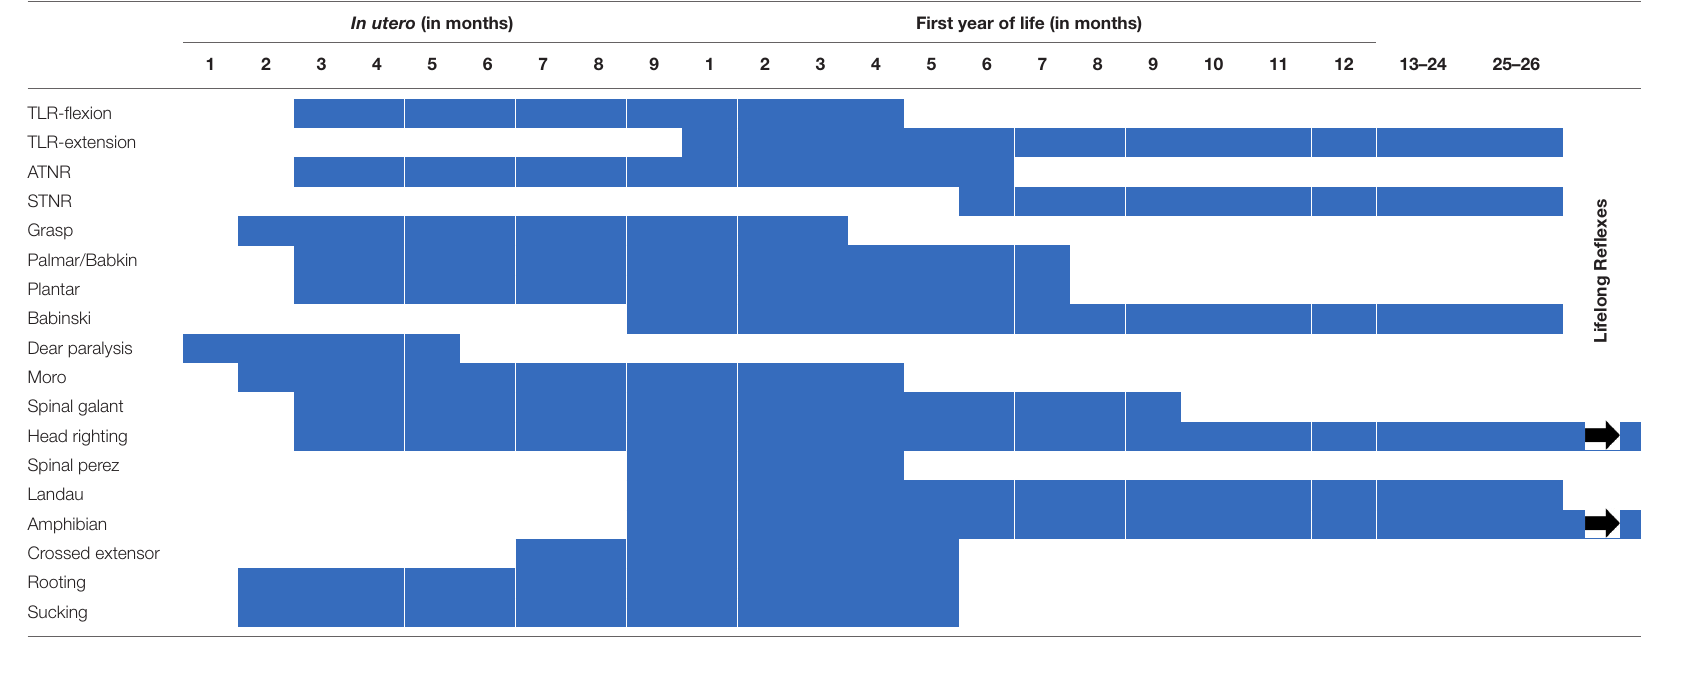
TABLE 1 | Primitive reflex development and integration